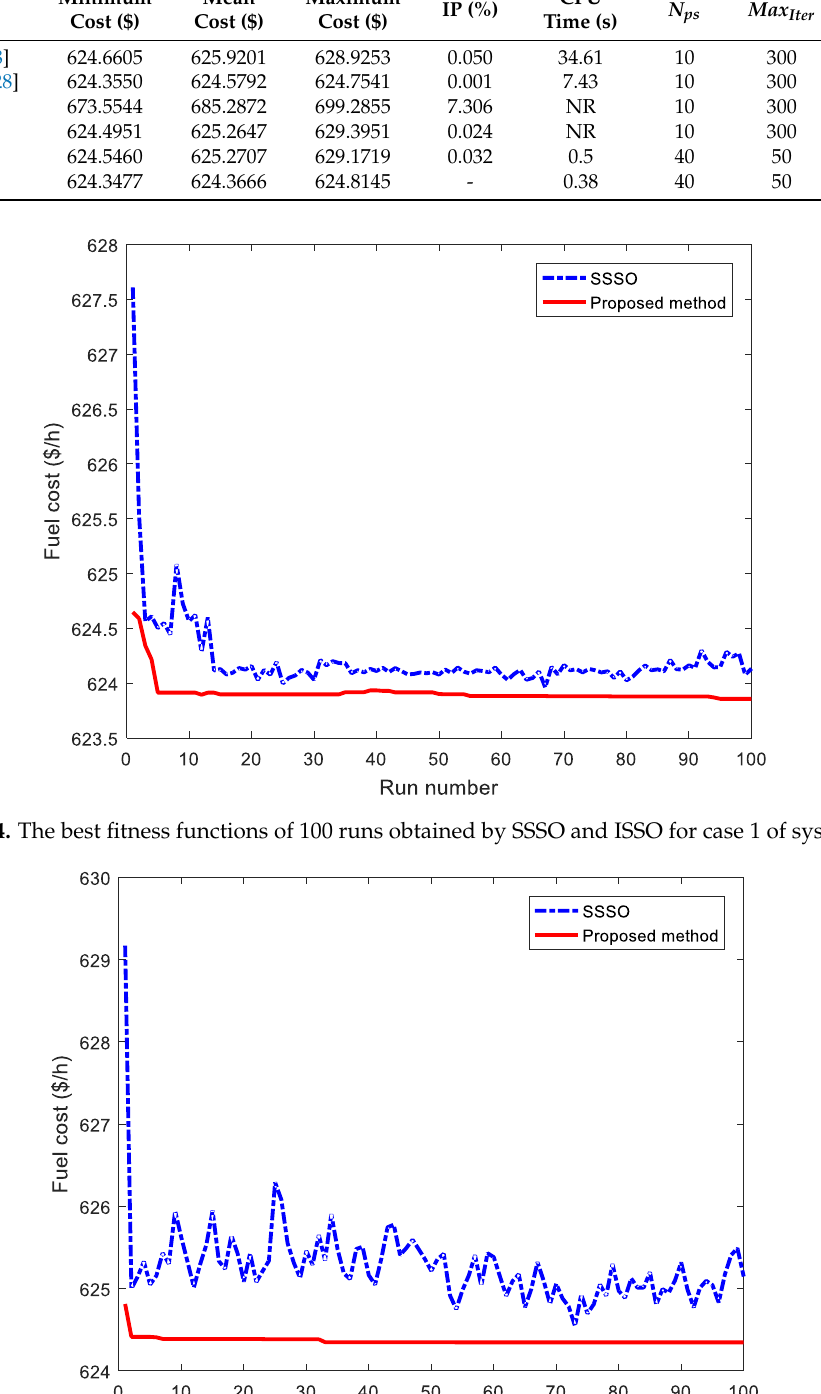
Figure 5. The best fitness functions of 100 runs obtained by SSSO and ISSO for case 2 of system 2.